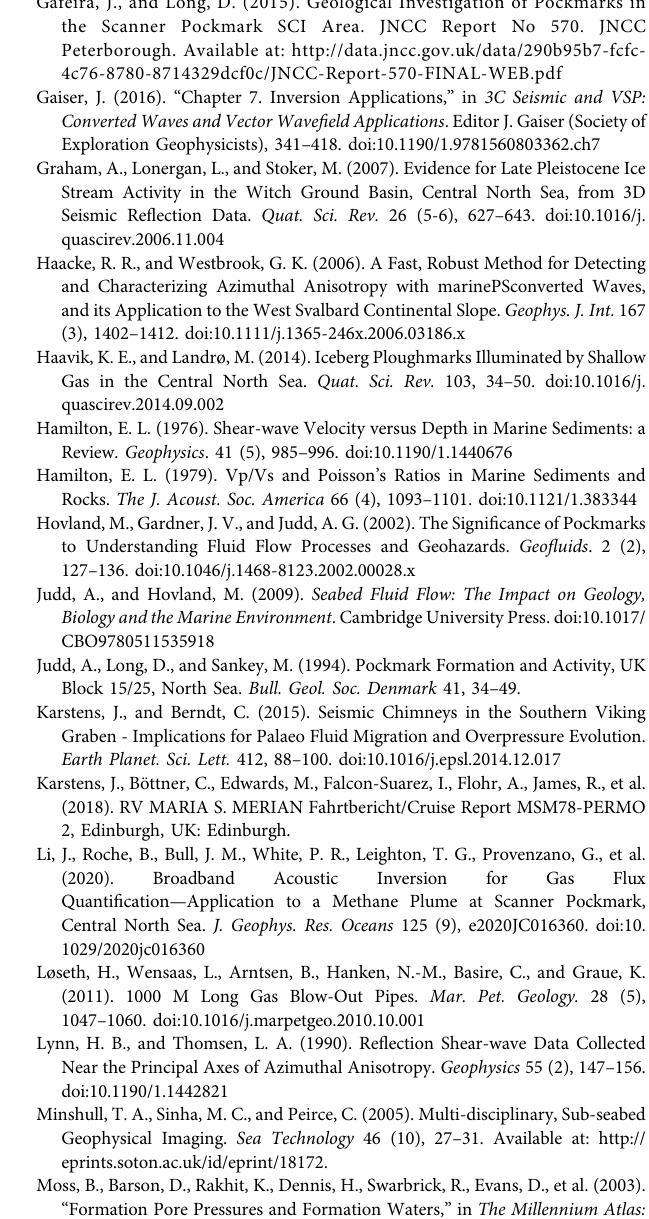
Figure S1 | The composite plot of radial and transverse components along an inline pro fi le recorded by 600 the OBS1. Even traces are the radial component and odd traces are the transverse component. Figure S2 | 2D seismic vertical seismic feature picking method. Individual sub- vertical discontinuities were picked along 104 pro fi le lines (black dots in map view – top left; and light blue in seismic cross-section view - below). Discontinuities that extended laterally across multiple 2D pro fi les were interpreted (black and red lines in mapview – topmiddleandright).Thediscontinuitiescorrespondtoiceploughmarks (black lines) and Mega-scale glacial lineations (red lines), respectively (Fig. 5.9). Figure S3 | 3D seismic surface of unit top S4, uninterpreted. A seismic amplitude horizon surface (left) and hillshade map (right) is displayed. Figure S4 | Laboratory S-wave measurements. Top: Input signal. Middle: output signal. Bottom: Frequency domain estimation of the S-wave